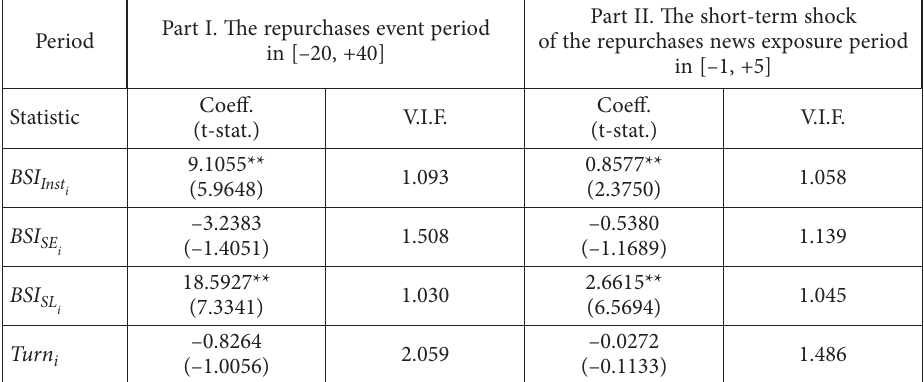
Table 3. The relationship between investor behaviors, market factors and repurchase stock price re- sponses